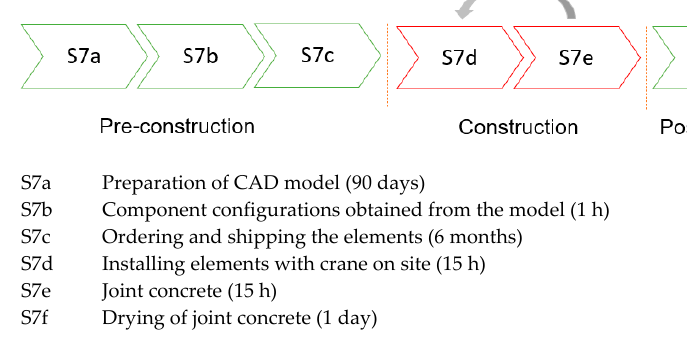
Figure 9. The process map for Scenario 7.